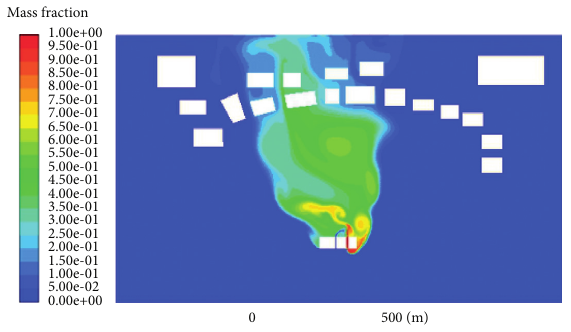
Figure 11: Radionuclide distribution rotating 90 ° clockwise at the southern break.